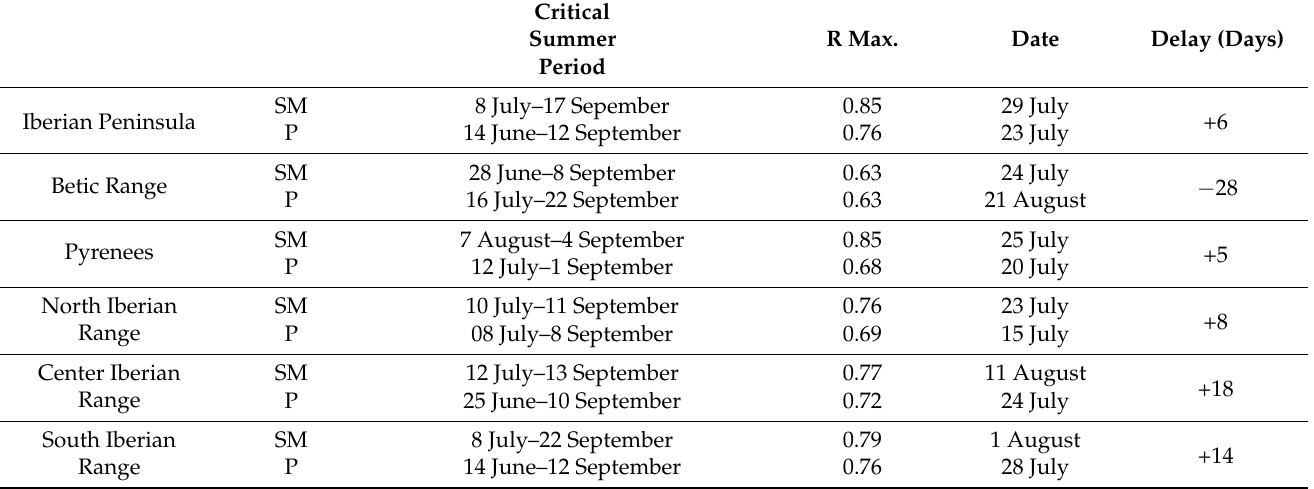
Table 4. Dates of the beginning and end of the critical summer period (R statistically significant), maximum value of correlation reached, date on which it was reached and delay between that maximum for soil moisture (SM) and precipitation (P). Critical Summer R Max. Date Delay Period